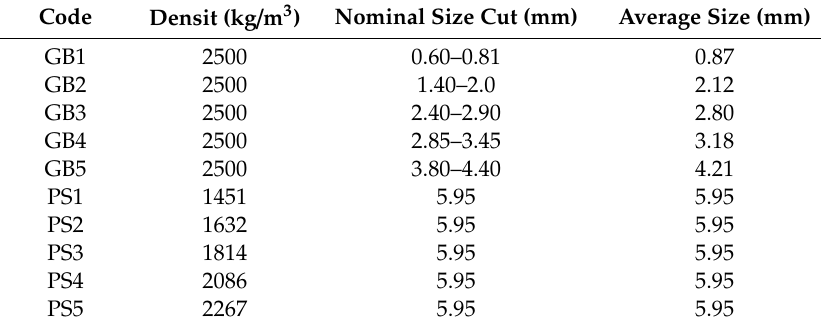
Table 1. Glass beads (GB) and calibrated plastic spheres (PS) properties.